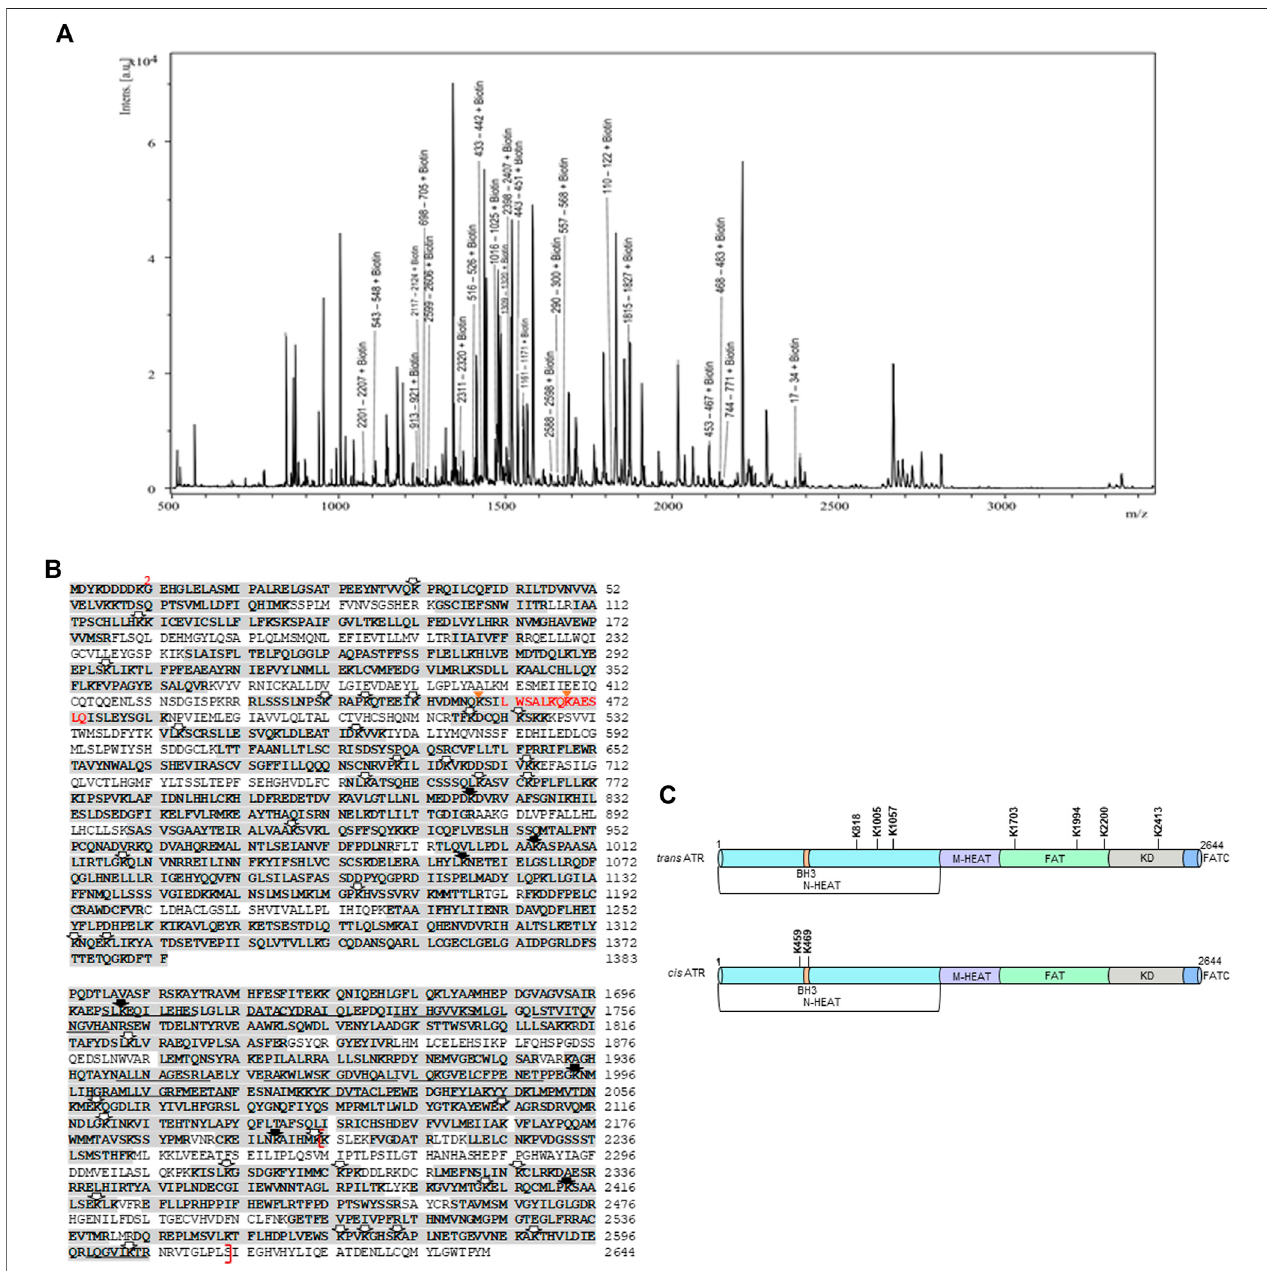
FIGURE 2 | MALDI-TOF and nano LC-MS/MS analysis of biotin-modi fi ed cis - and trans -ATR. (A) Typical MALDI-TOF mass spectrum of peptide fragments resultingfromtrypsindigestionofbiotin-modi fi ed cis- ATR. (B) SequenceofN-HEAT,FAT,KD,and FATCdomainsofFLAG-taggedATRprotein. Theinitialmethionineis part of the FLAG tag, and the fi rst amino acid corresponding to ATR is marked as 2. Amino acid sequences corresponding to tryptic peptide fragments detected by MALDI-TOF and nano LC-MS/MS are indicated by the shading. The lysine residues modi fi ed by NHS-biotin treatment for all trans - and cis - and WT ATR are indicated by open arrows, whereas unique biotin-modi fi ed lysine residues were observed for trans -ATR (solid arrow) and cis - and WT ATR (gold triangle). The BH3 domain(aa461-474)isdesignatedbyredcolor,andthekinasedomain(aa2206-2615)isenclosedinredbrackets. (C) Summaryofuniqueanddifferentialbiotin-modi fi ed lysineresiduesbetween trans -and cis -ATRidenti fi edbyMALDI-TOFandnanoLC-MS/MS inthecontextoftheATRstructure.N-HEAT,N-terminalHEATrepeats;BH3, BH3-like domain; M-HEAT, middle HEAT repeats; FAT, FRAP, ATM, TRRAP domain; KD, kinase domain; FATC, FAT C-terminal domain.